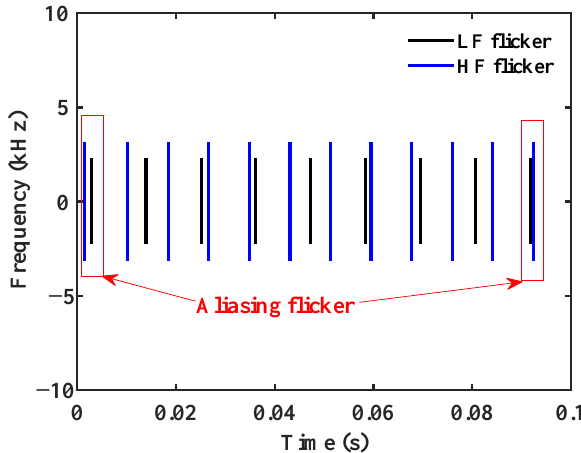
Figure 14. Time–frequency spectrum full flashing time domain location tag